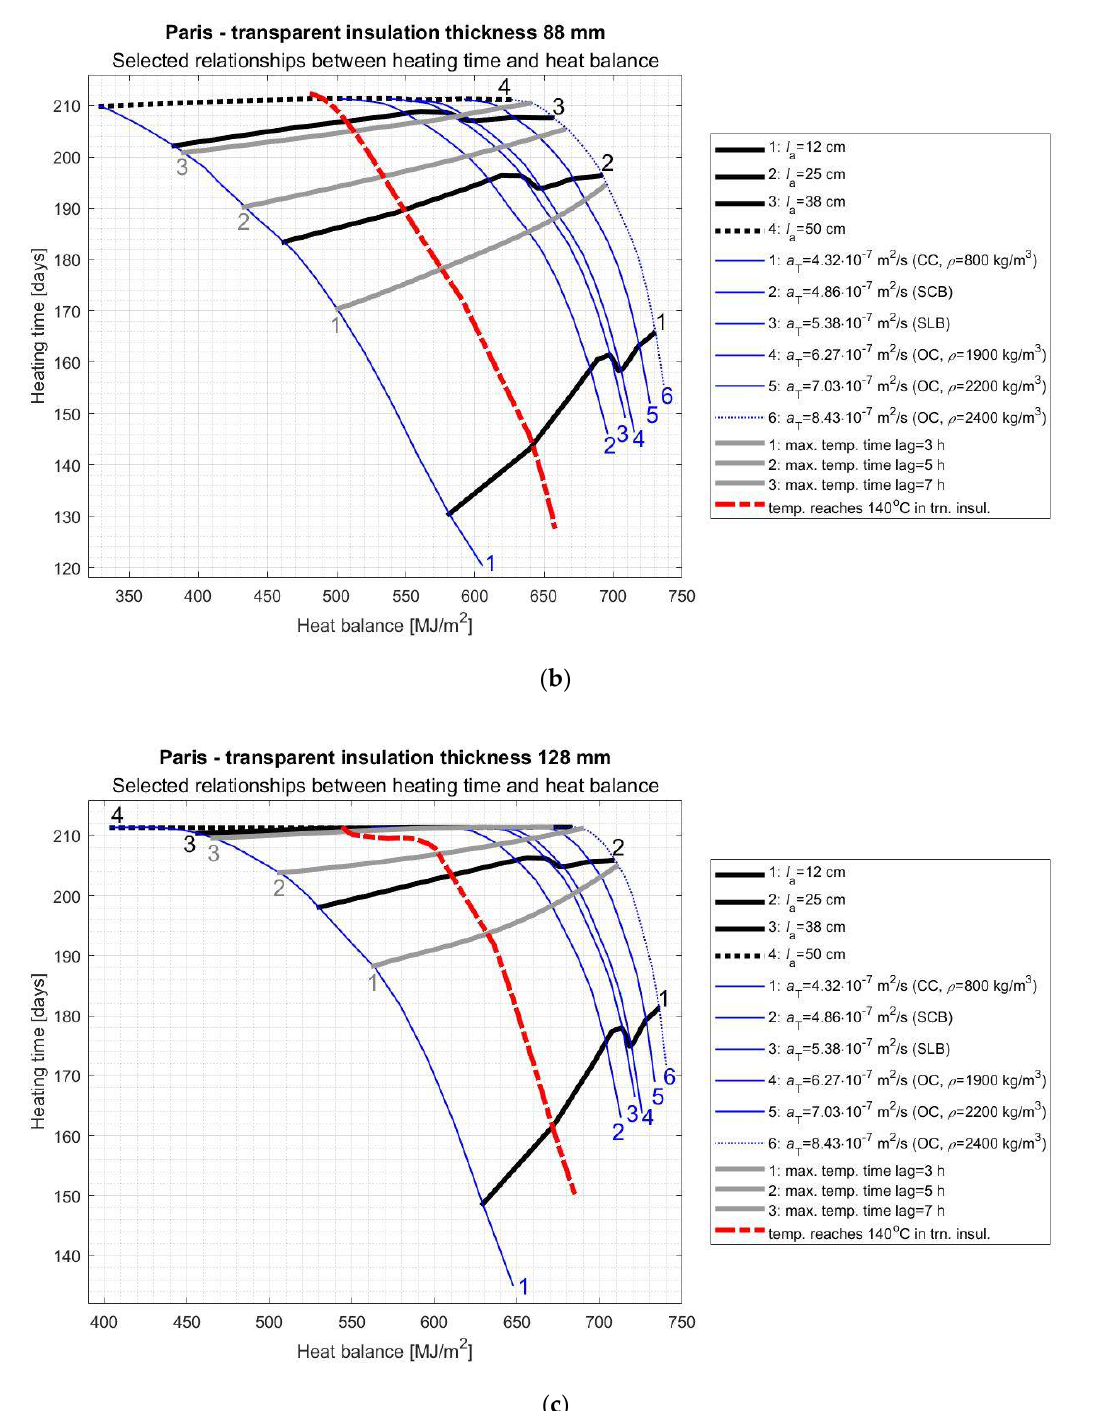
Figure 10. Relationship between the heating time and heat balance for the AL depending on its selected most important features. TI thickness: ( a ) 48 mm, ( b ) 88 mm, ( c ) 128 mm. Location: Paris.